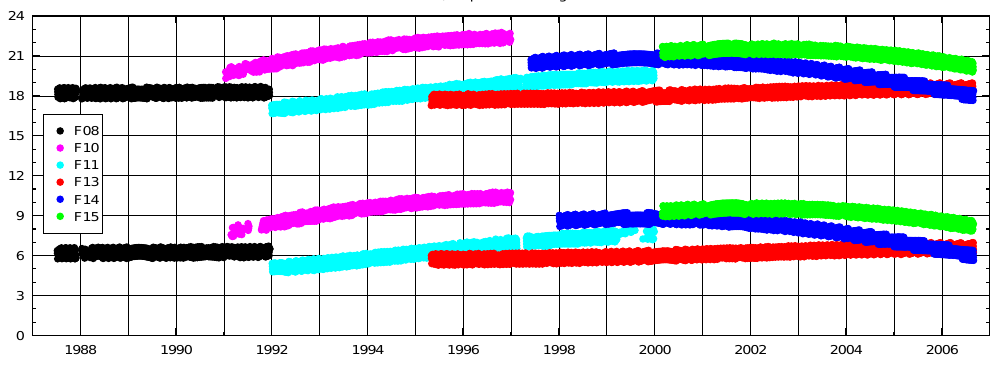
Figure 2. Local Equator crossing times of the DMSP